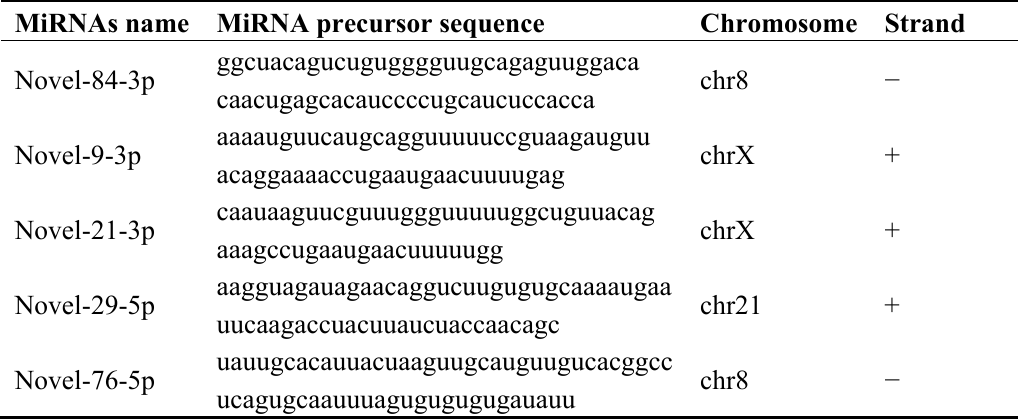
Table 3. Predicted precursor sequences and genome locations of five novel